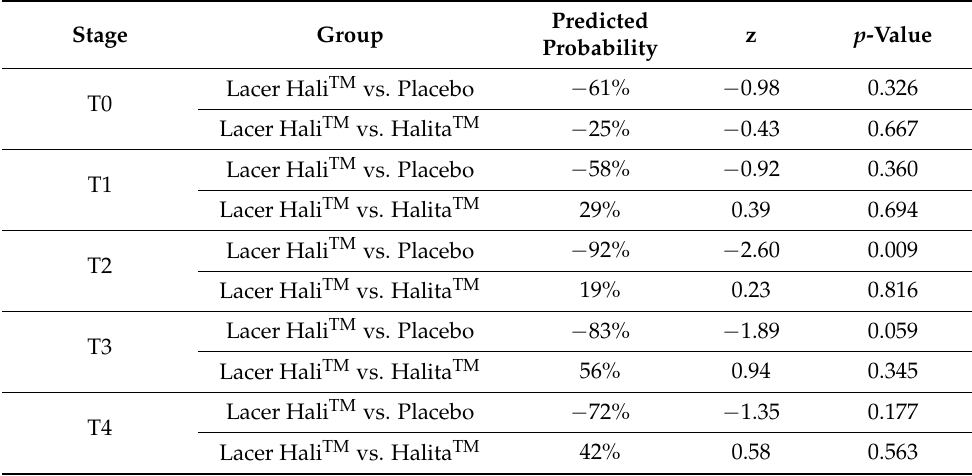
Table 3. A cumulative logit mixed model was fitted to evaluate the difference between Lacer Hali TM vs. Halita TM and Lacer Hali TM vs. placebo treatments at different time points during the organoleptic evaluation. Statistically significant p -value < 0.05.